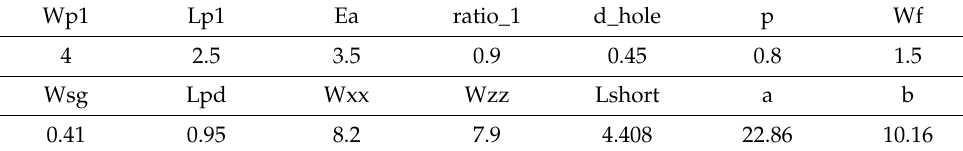
Table 1. Structure parameters of the transition with RT/Duroid 6010 substrate (unit: mm). Wp1 Lp1